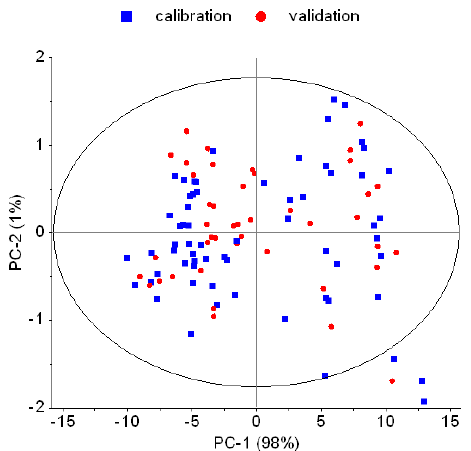
Figure 1. Score plot of principal component analysis (PCA) using raw infrared spectra (log 1/R) with Hotelling’s T 2 ellipse for outlier inspection. Calibration samples (squares) and validation samples (circles) are marked accordingly. PC: principal component.